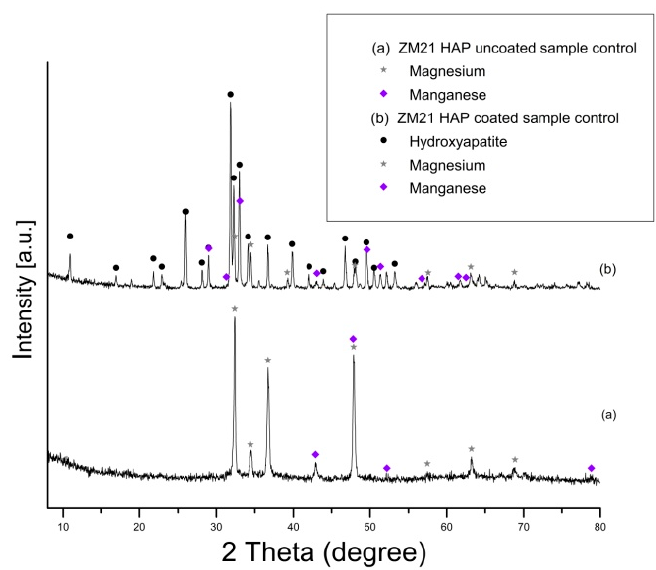
Figure 5. XRD patterns of uncoated ( a ) and hydroxyapatite (HAP) coated ( b ) ZM21 alloy (bullets indicate the peaks corresponding to diffraction angles of the main phases).